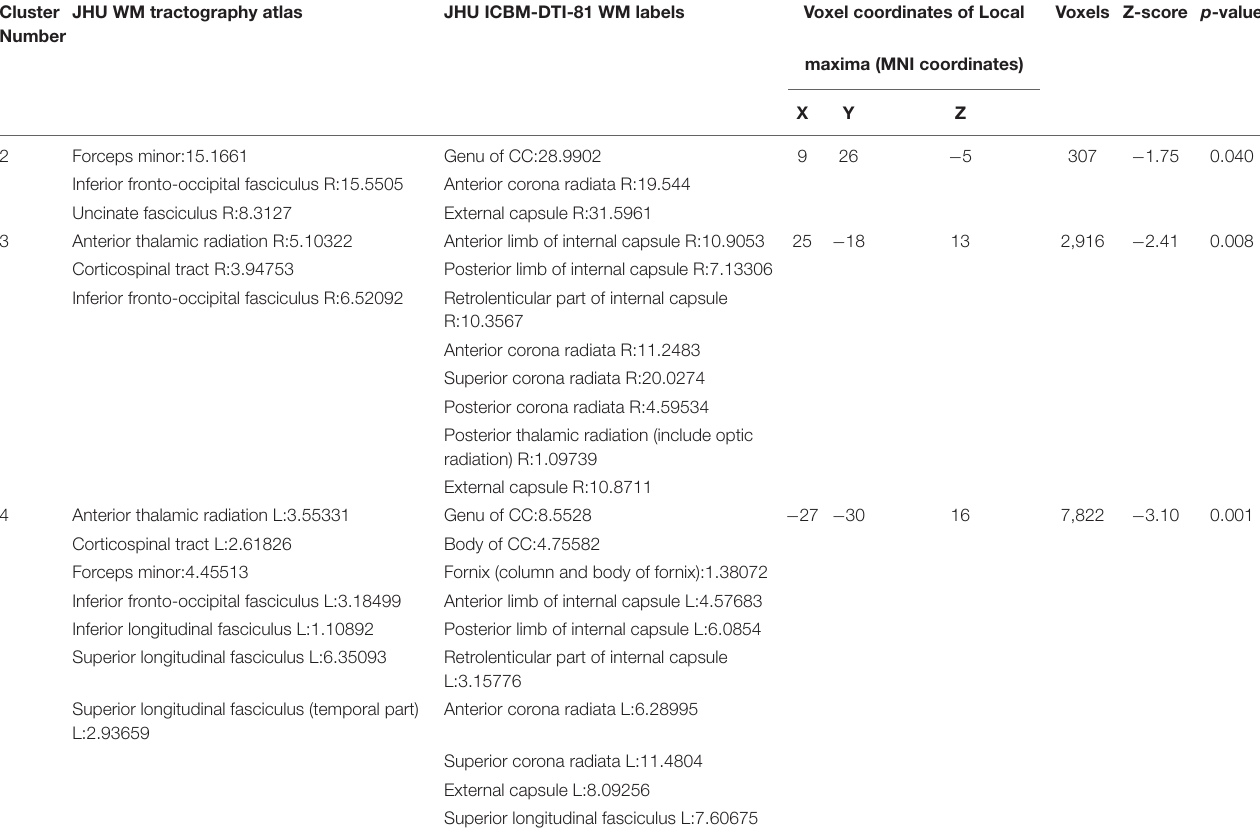
TABLE 3 | Cluster sizes and locations for voxels with significantly increased AD in ESRD vs. NES-CKD groups. Cluster JHU WM tractography Number